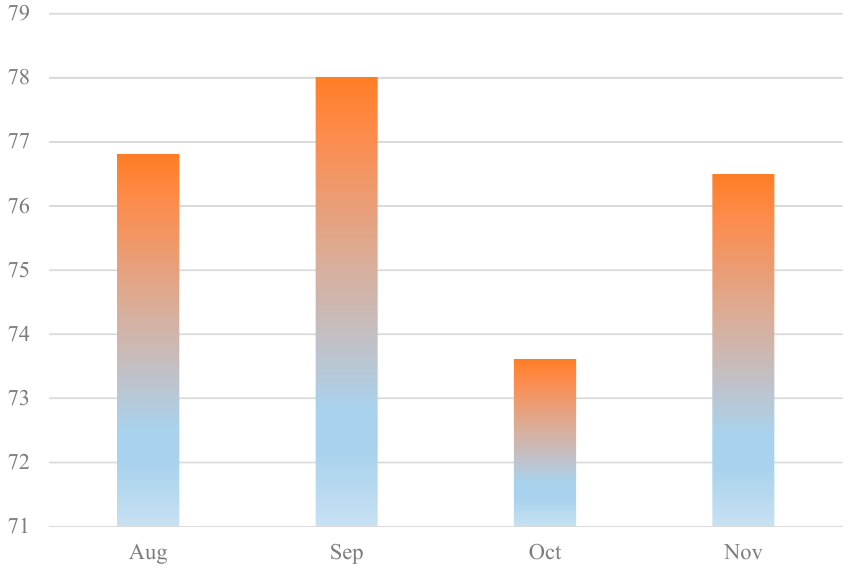
Figure 18. Performance ratio by the PV subsystem.